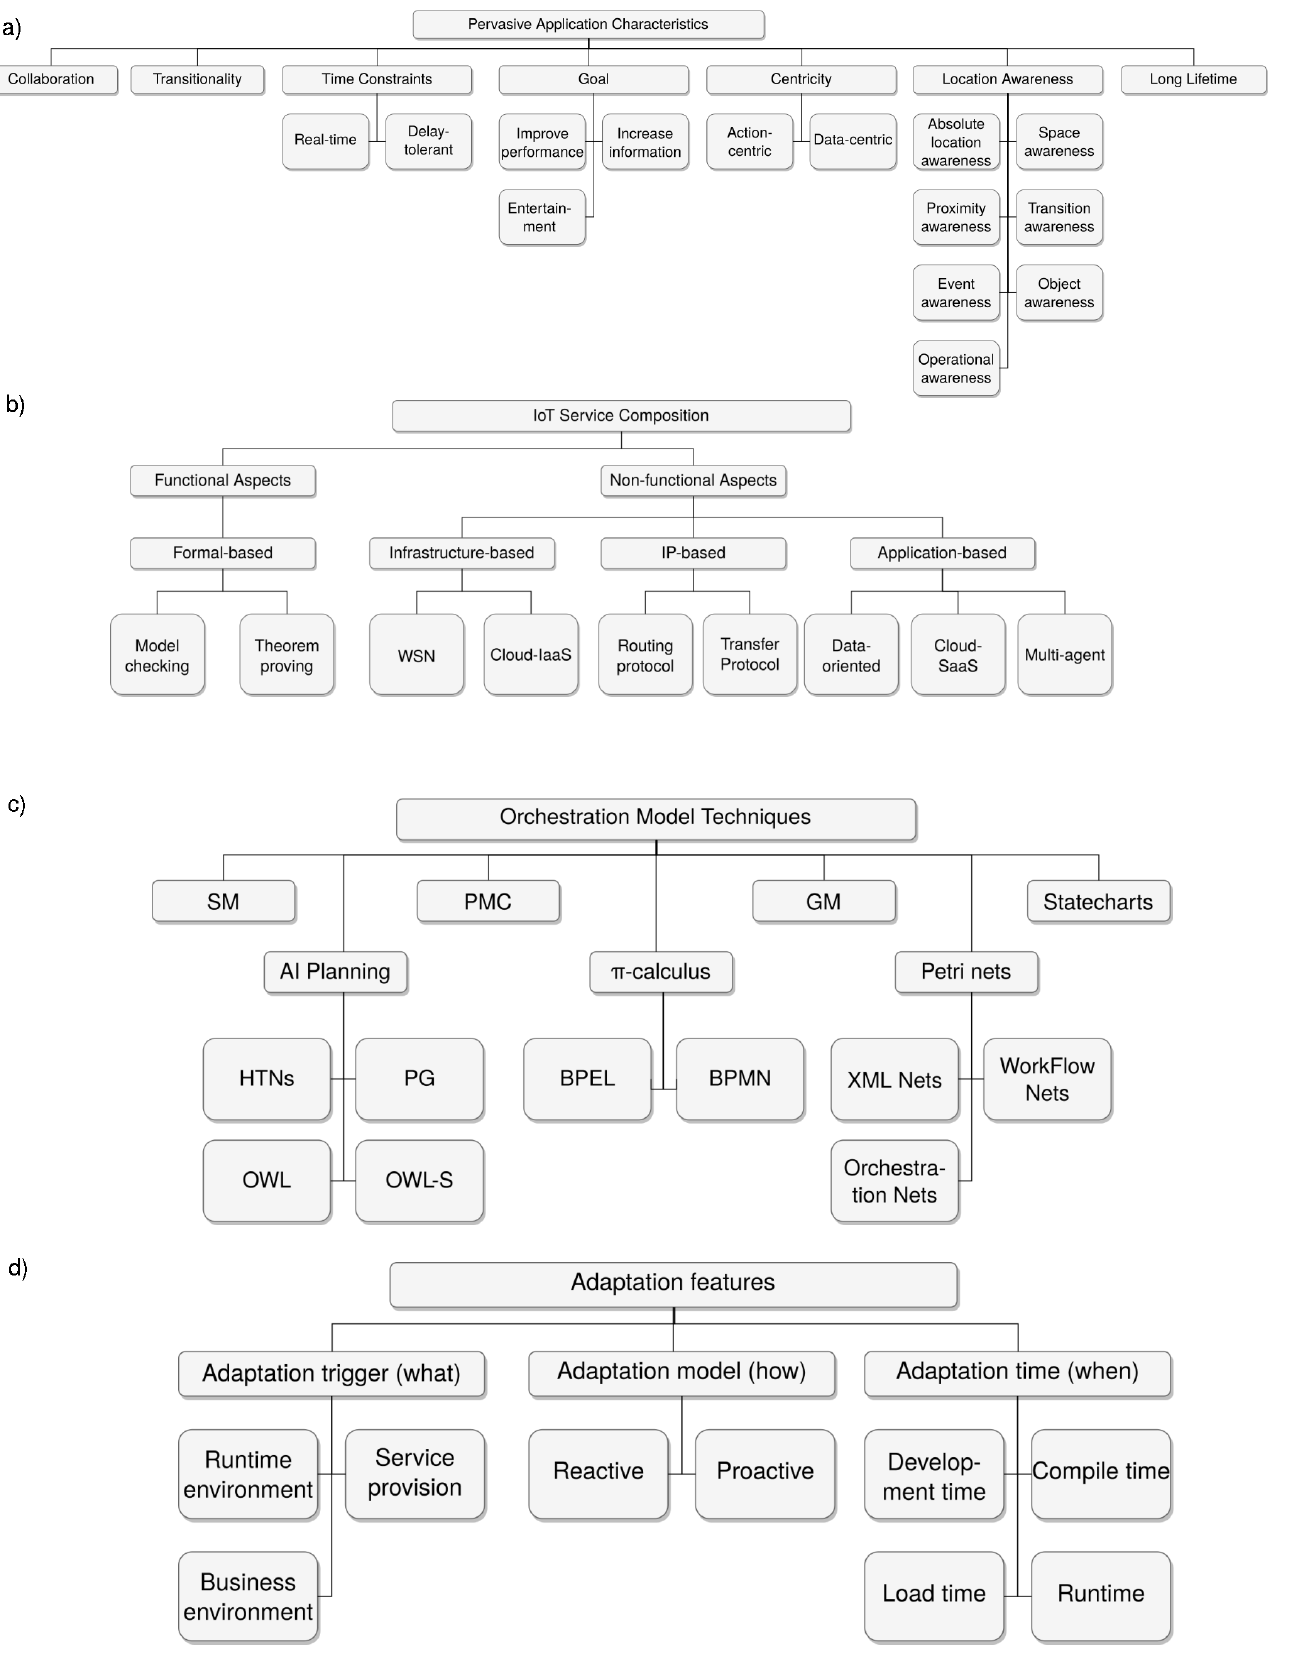
Figure 1. Figures corresponding to the classifications of Dombroviak ( a ), Asghari ( b ), Petrova-Antonova ( c ) and Mutanu ( d